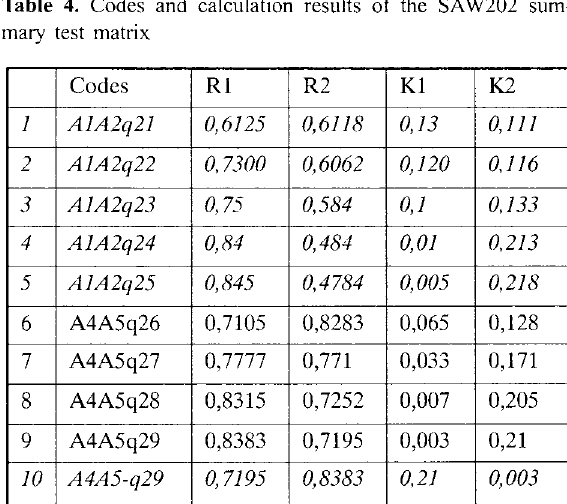
Table 6. Values of elements of the TOP I 0 test matrix of